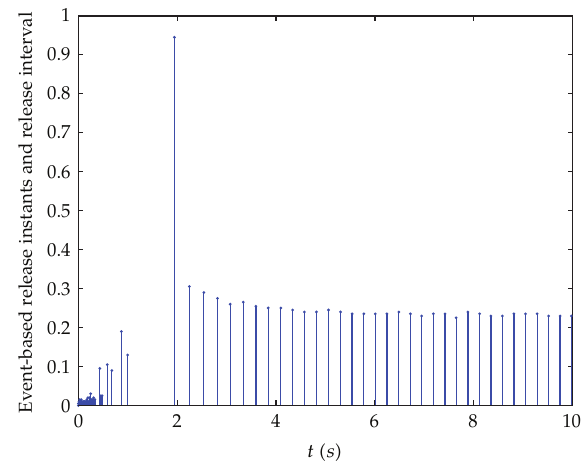
Figure 3: Release instants and release interval by event-triggered